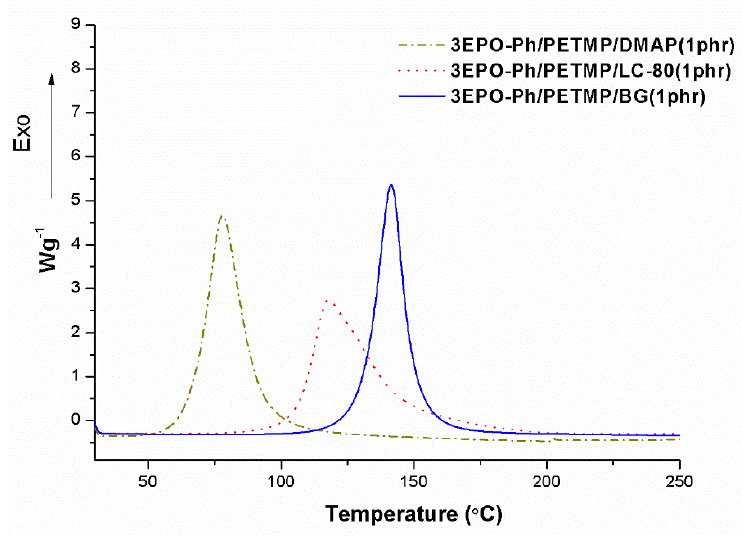
Figure 4. Calorimetric curves of the initial mixture 3EPO-Ph / PETMP formulations with 1 phr of the different catalysts.